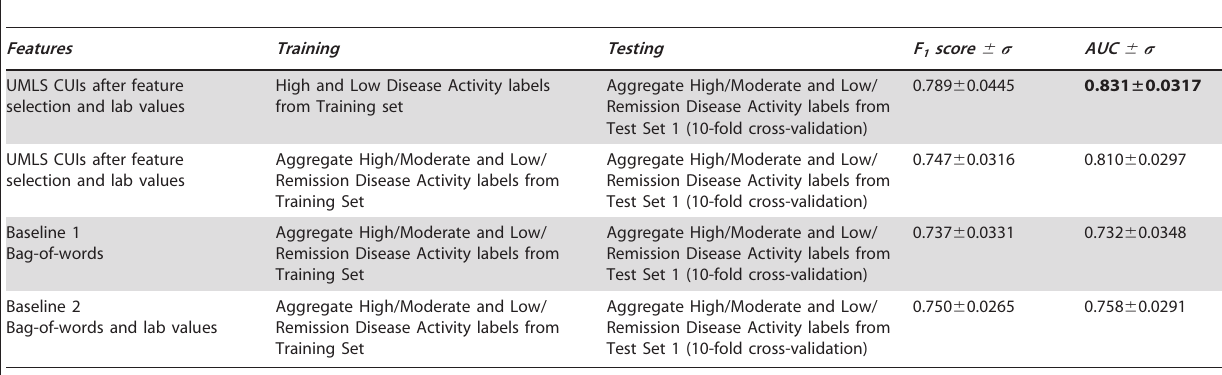
Table 2. Corpus selection effect on Test set 1 using a linear-kernel SVM model.